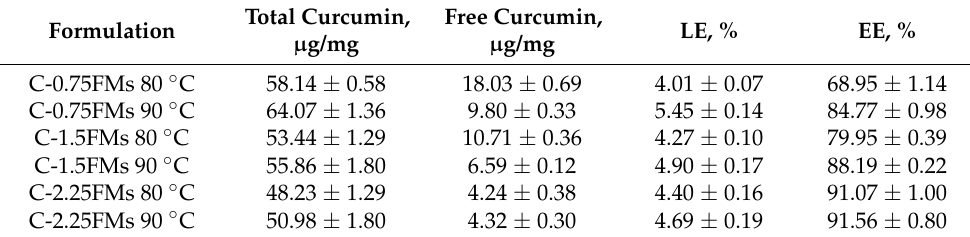
Table 2. Properties and analysis of drug loading efficiency and encapsulation efficiency.